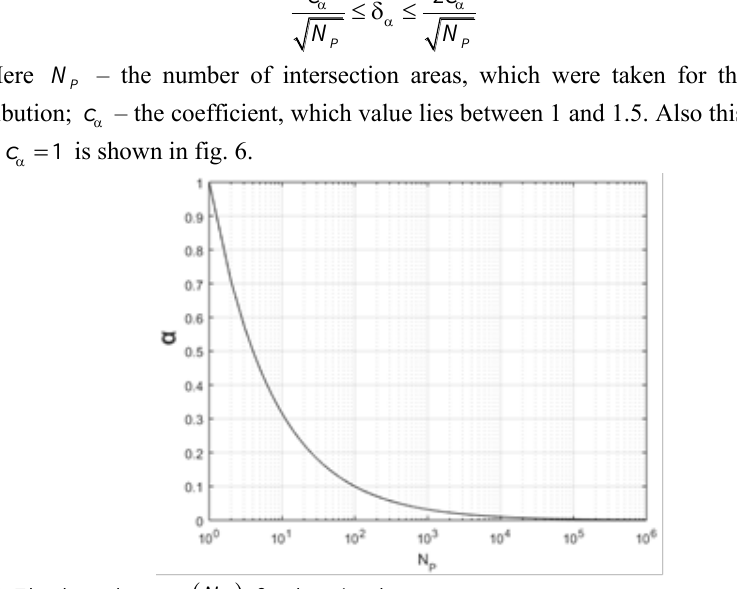
Fig. 6. The dependency  